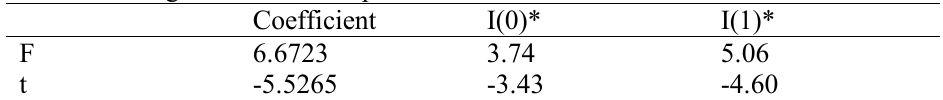
Table 5. Long-term relationship